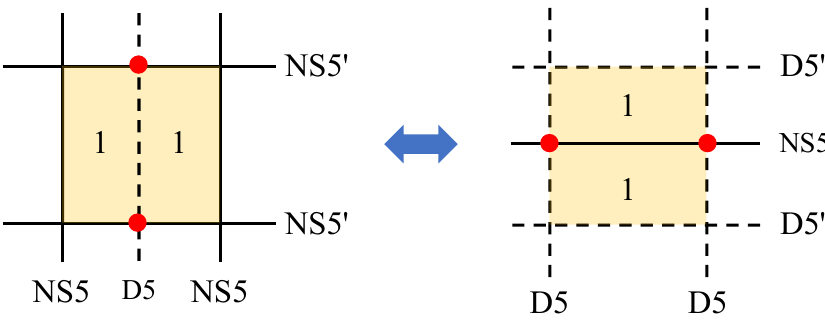
Figure 1 . The brane box configurations of 2d hypermultiplet and two charged Fermi multiplets and of its mirror take the horizontal and vertical directions along the x 6 and x 2